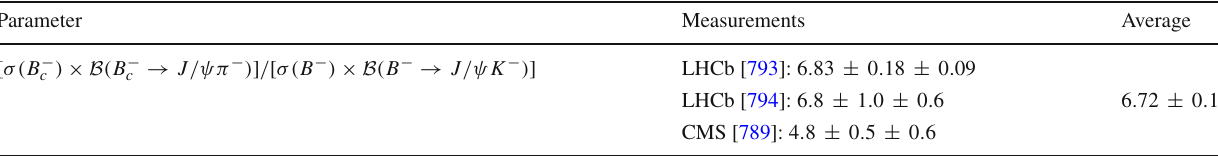
Table 204 Relative production times decay rates [ 10 − 3 ]